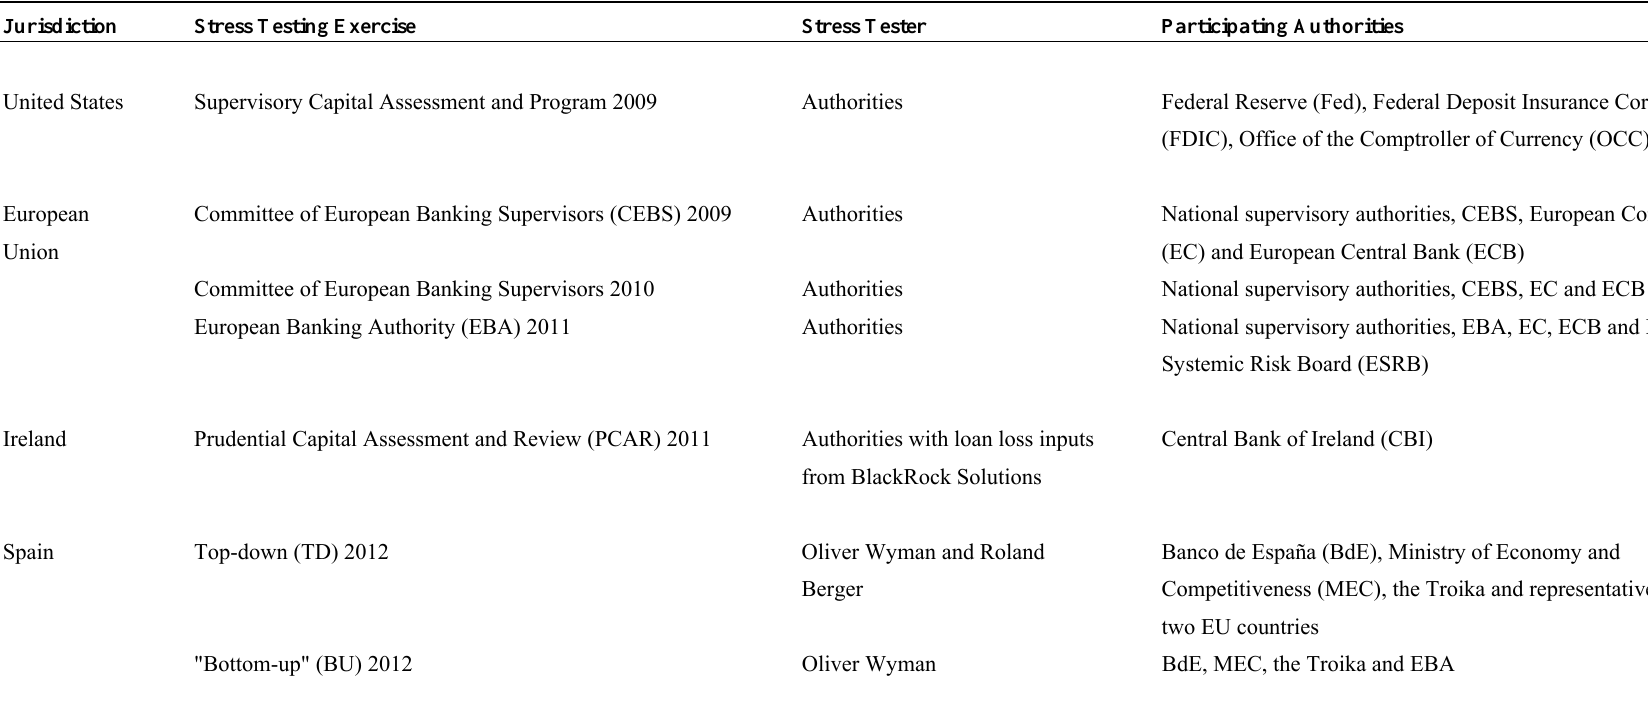
Table 1. Case Studies: Crisis Stress